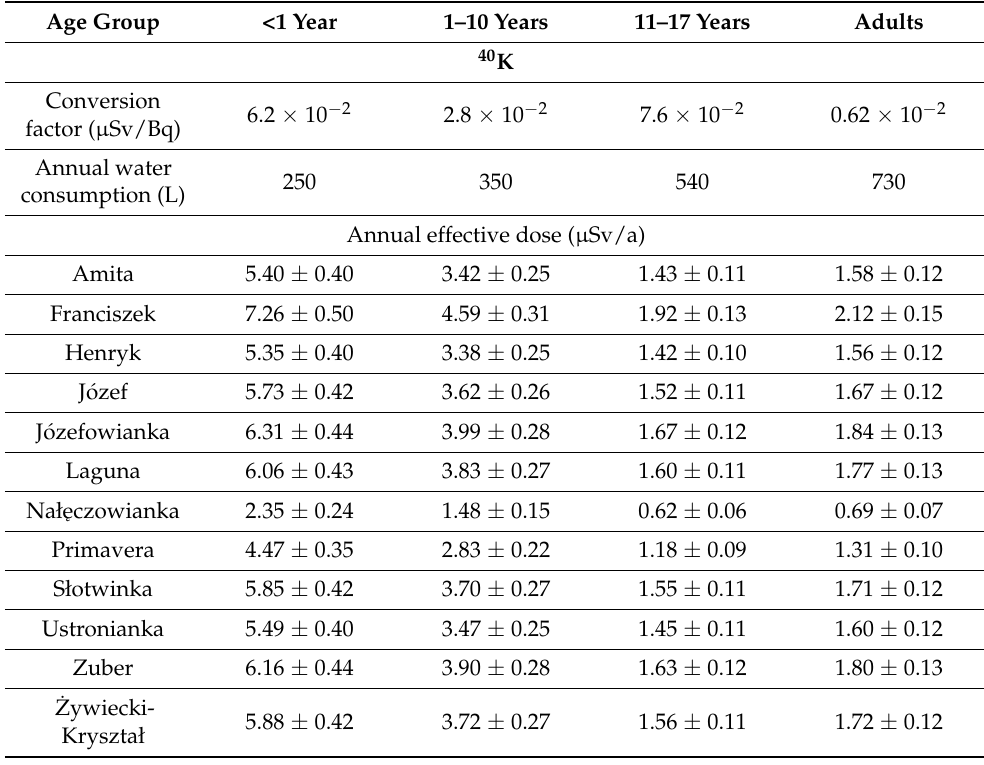
Table 2. Average annual effective doses of 40 K potassium uptake in drinking water in the tested mineral water samples.